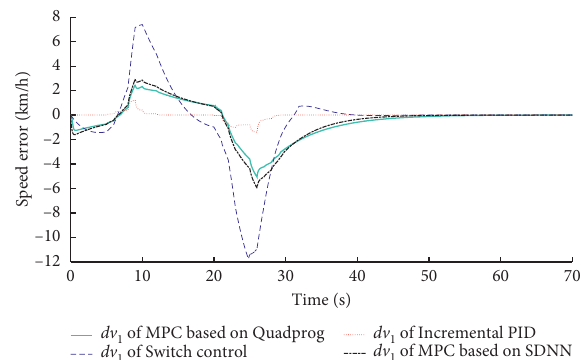
Figure 12: Speed errors of the LV and the FV of four